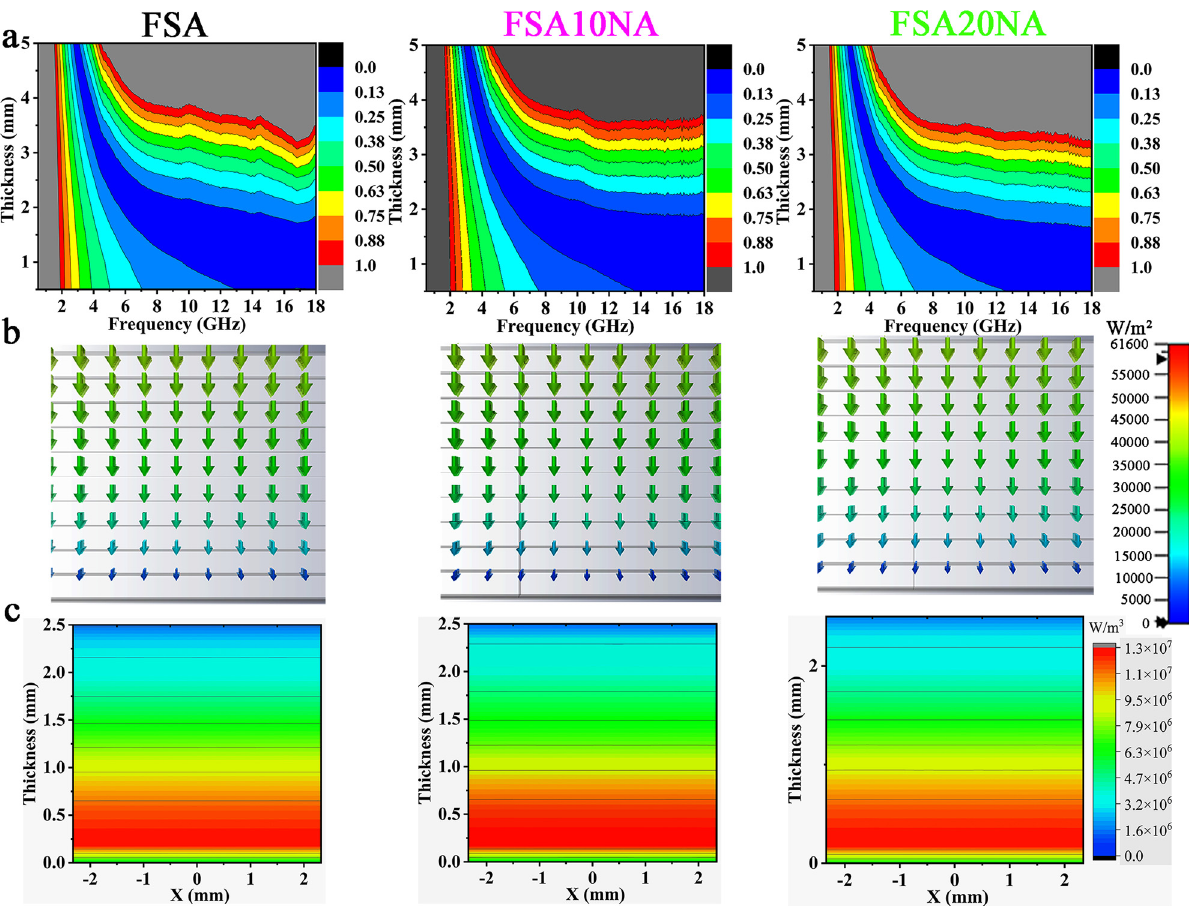
Figure 6: ( a ) The calculated data maps of FSA, FSA10NA, and FSA20NA at 0.5 – 18 GHz. ( b ) Power fl ow and ( c ) power loss density distribution images of FSA, FSA10NA, and FSA20NA under 2.5 mm at 13.36